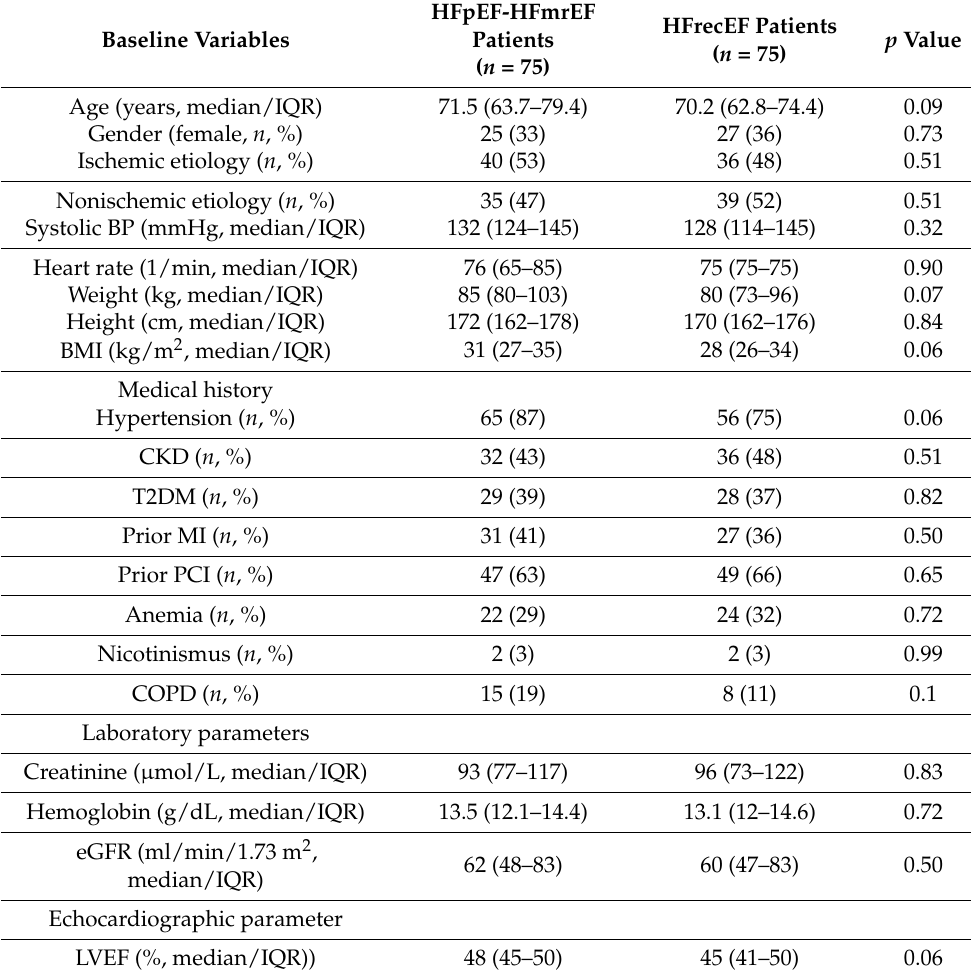
Table 3. Baseline clinical characteristics of HFpEF-HFmrEF and HFrecEF